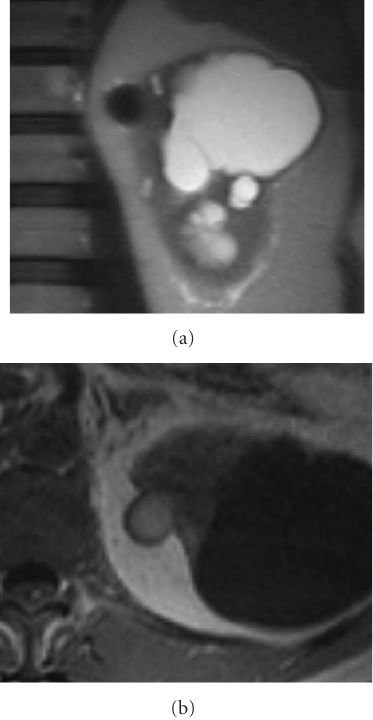
Figure 11: (a) Coronal haste T2 and (b) axial precontrast T1: small lesion on medial aspect of the upper pole of the left kidney shows a low signal intensity on T1 and hyperintensity on T1, revealing blood breakdown products consistent with haemorrhagic